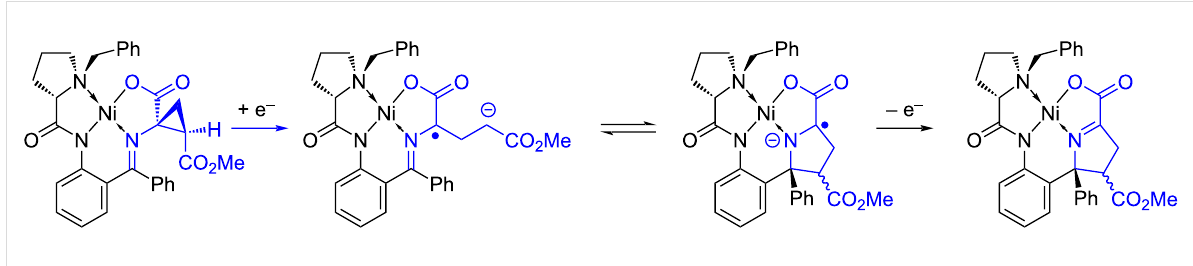
Scheme 3: Electrochemically induced ring-opening followed by intramolecular cyclization.